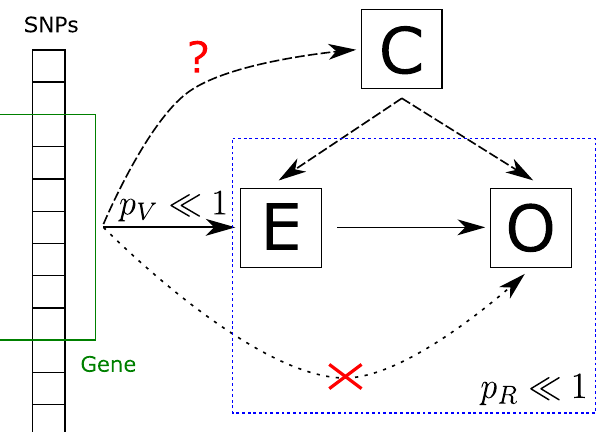
Fig 3. Interpretation of the ratio test. The test detects potential gene-wise causal relations between a GWAS trait viewed as exposure (E) and a GWAS trait viewed as outcome (O). The association of the exposure has to be confirmed independently via a standard gene enrichment test. Potential confounders (C) have to be excluded by other means.